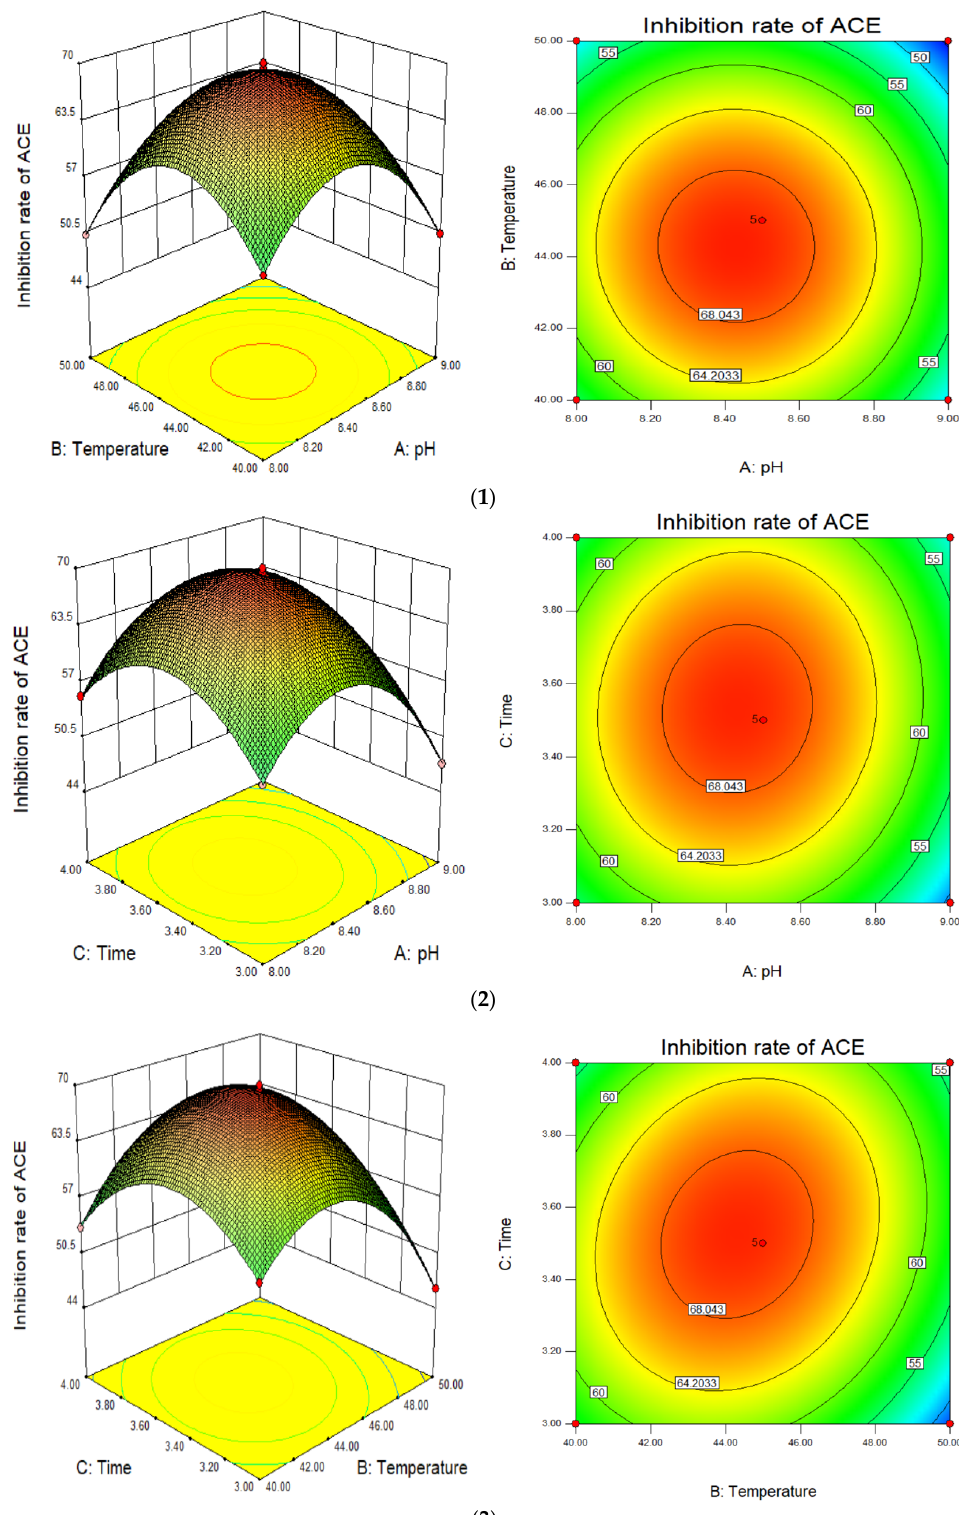
Figure 7. Response surface interaction diagram. ( 1 ) shows the interaction between pH and temperature. ( 2 ) shows the interaction between pH and time. ( 3 ) show the interaction between temperature and time.